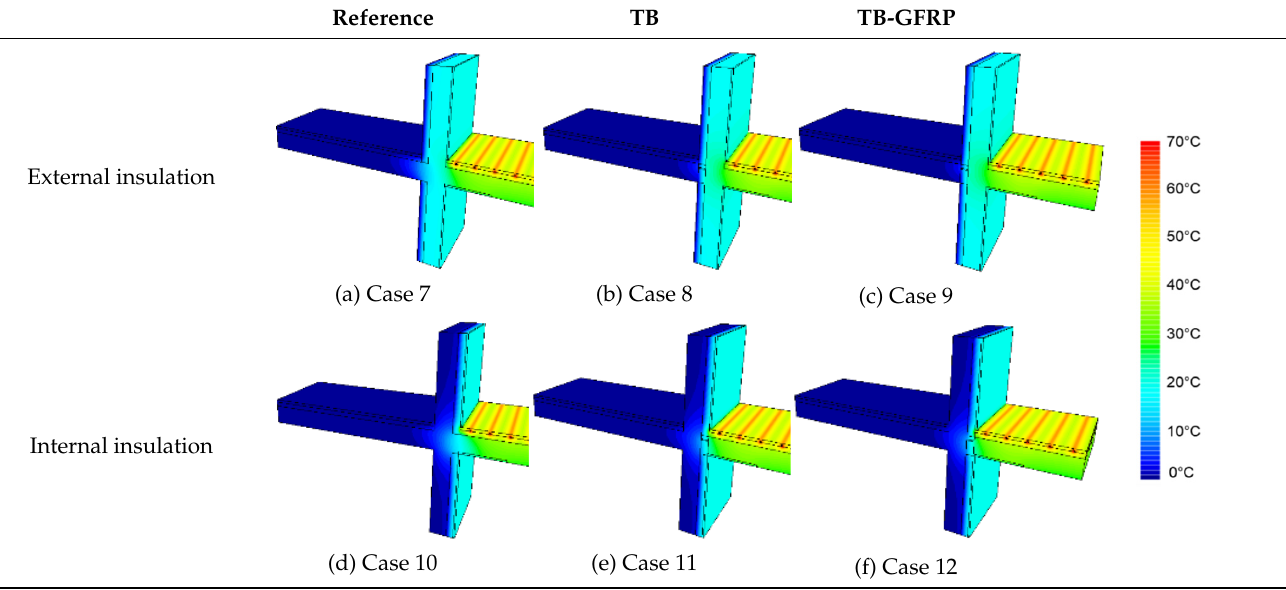
( b ) Figure 6. Simulation results under radiant floor heating condition: ( a ) Heat flow through the bal- cony–slab thermal bridge; ( b ) ψ -value. The effect of thermal breaks on the heat flow reduction can be clearly evaluated using ψ -values. With the external insulation system, the ψ -value was 1.159 without thermal break (reference case), while it was reduced down to 0.423 W/mK ( − 63.5%) for TB and to 0.330 W/mK ( − 71.6%) for TB-GFRP. With the internal insulation system, the ψ -value of the